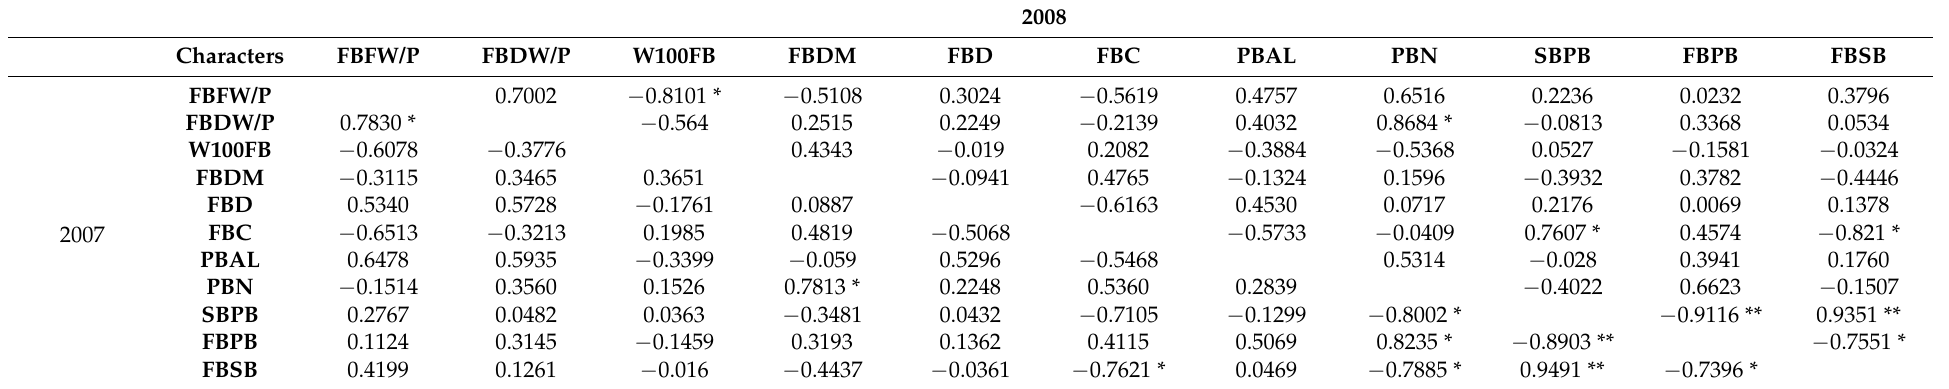
Table 3. Correlation matrix of biometric and production